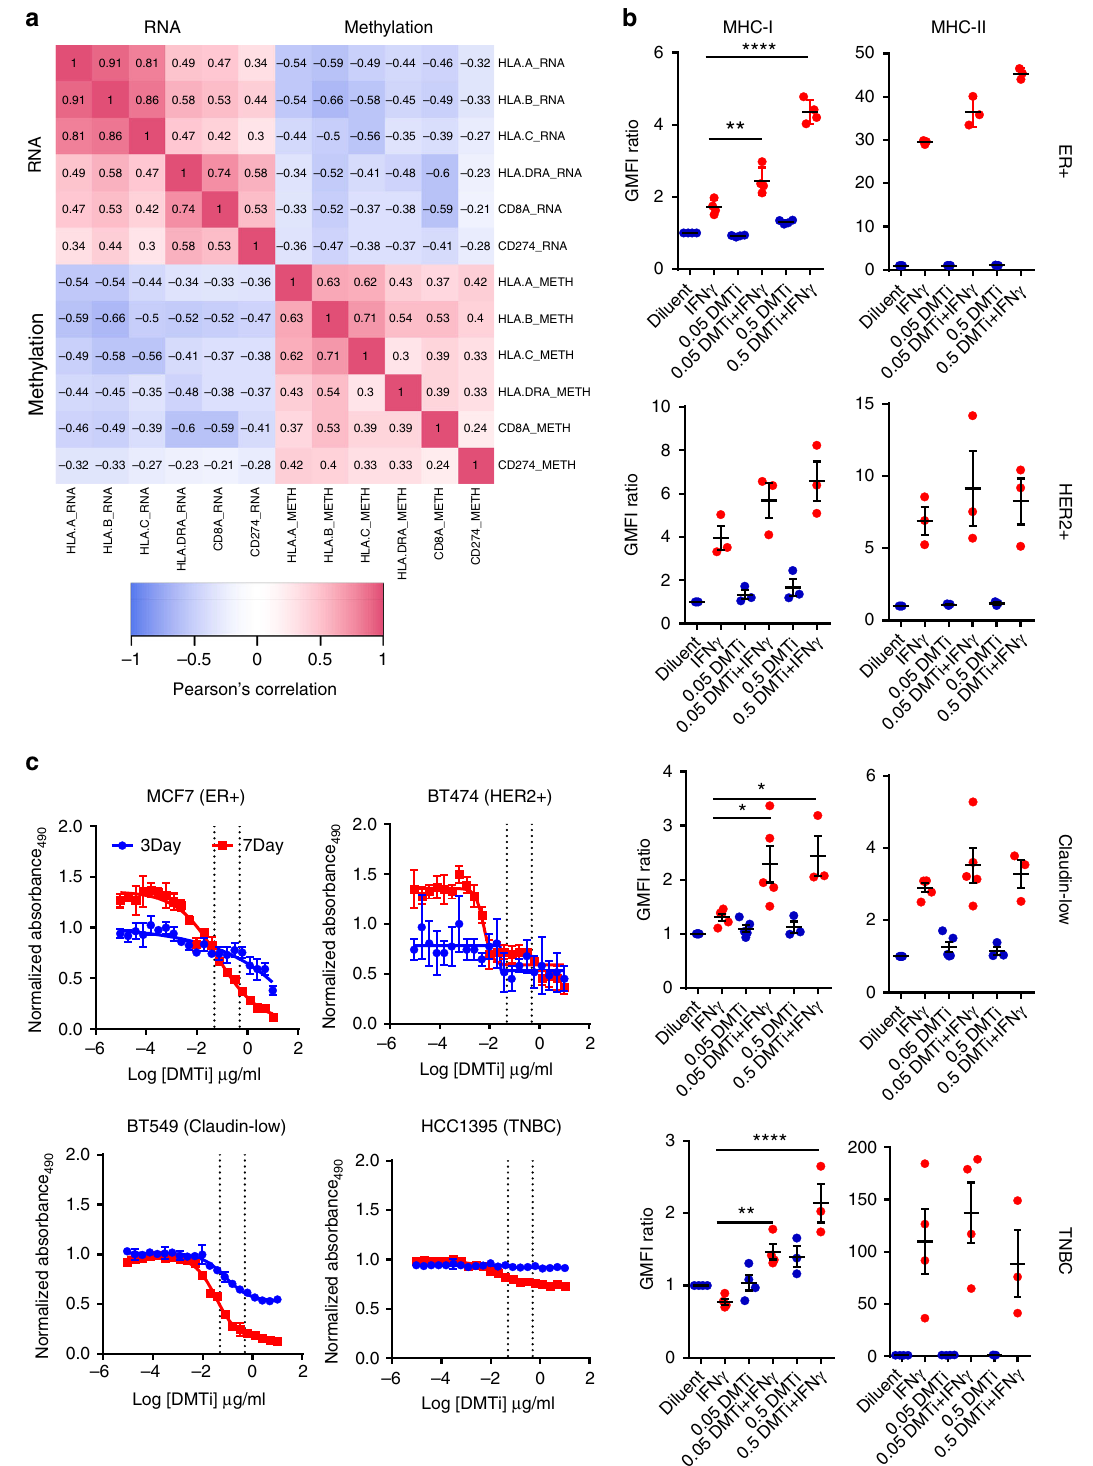
Fig. 1 DMTi treatment augments MHC-I and MHC-II expression of human breast cancer samples. a Correlation matrix of methylation status and mRNA expression of MHC-I (HLA-A/B/C), MHC-II (HLA-DRA), and PD-L1 (CD274) from TCGA breast cancer patient data. Pearson ’ s correlation coef fi cients are shown in box. b Geometric mean fl uorescence intensity (GMFI) ratio of MHC-I and MHC-II in multiple subtypes of human breast cancer cell lines (ER +/MCF7; HER2+/BT474; Claudin-low/BT549; TNBC/HCC1395) under guadecitabine (DMTi) treatment + IFN γ stimulation. GMFI ratio of diluent group was used as the baseline. * p < 0.05; ** p < 0.01; **** p < 0.0001 (one-way ANOVA with Tukey ’ s multiple comparisons correction to compare individual groups). All data are means ± SEM. Each dot represents one independent experimental result. c Viability assay of multiple subtypes of human breast cancer cell lines (ER+/MCF7; HER2+/BT474; Claudin-low/BT549; TNBC/HCC1395) under DMTi treatment. All data are means ±